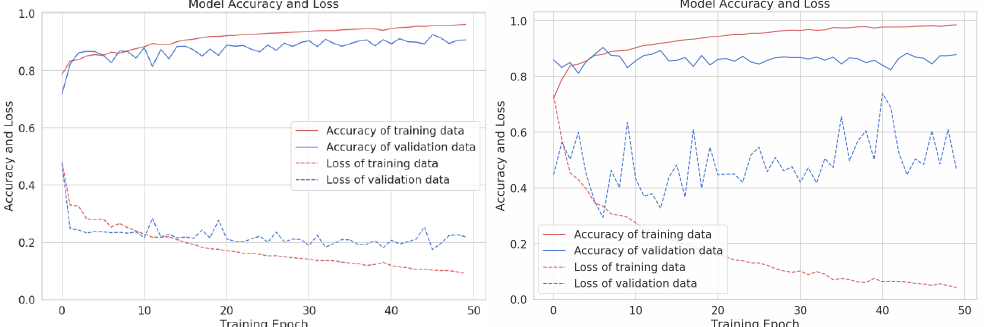
Figure 5. The training and testing evolution for the chest workout ( left ) and back workout ( right ) for each training epoch.